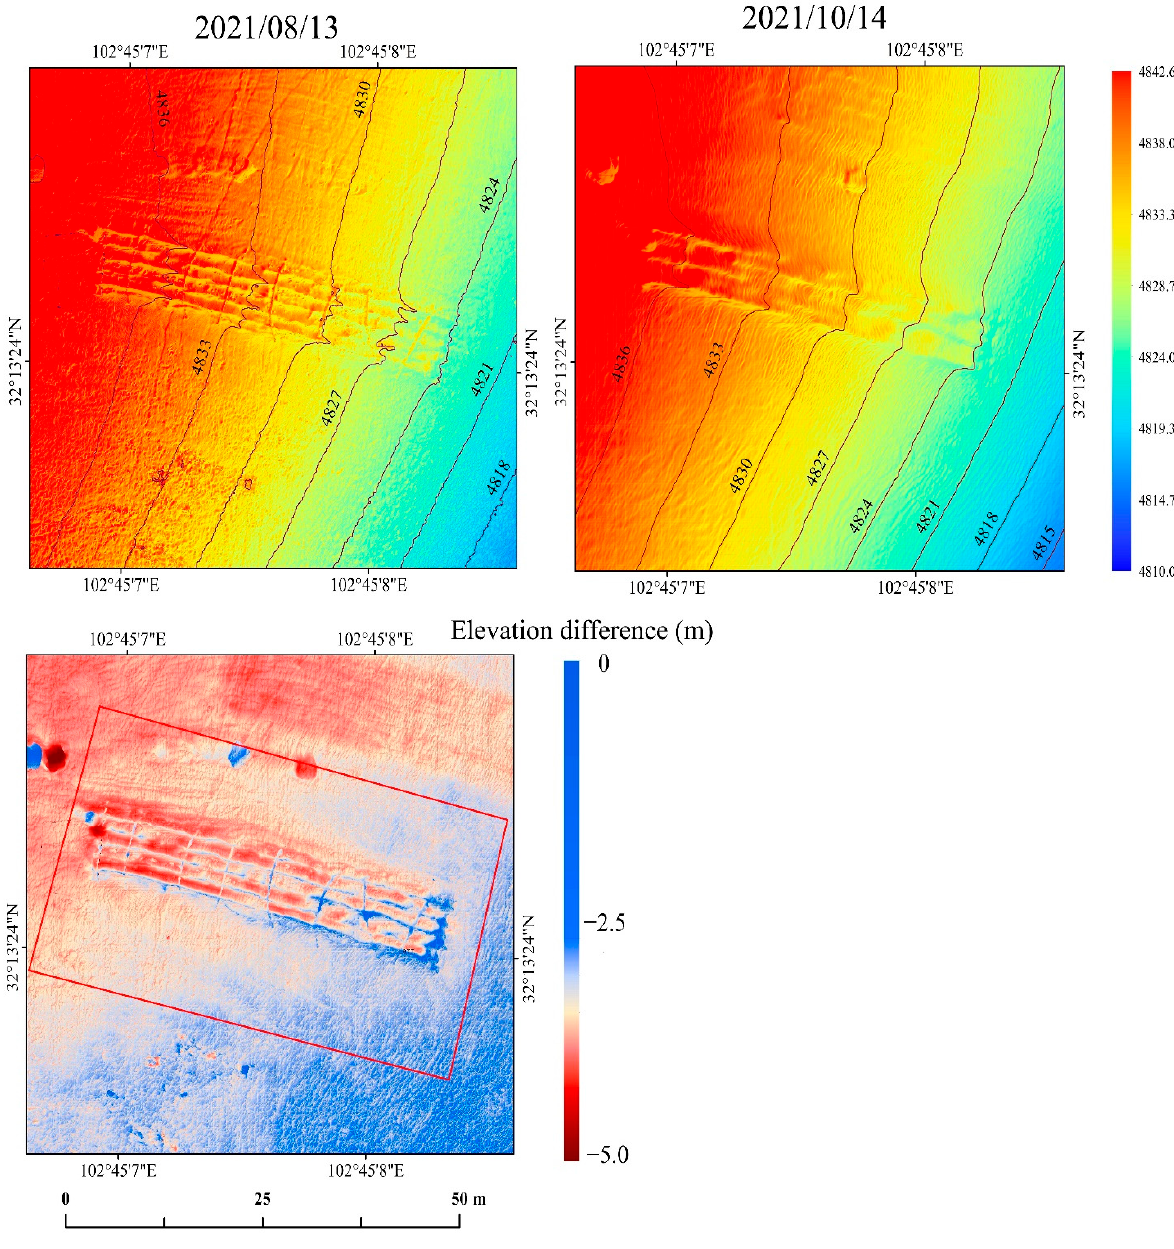
Figure 7. Surface DEM maps and elevation differences for the UAV surveys of DG17 conducted on 13 August 2021 and 14 October 2021. The contour lines are indicated by brown lines, and the area in the red box represents the comparison between the covered and uncovered areas depicted in Figure 8.